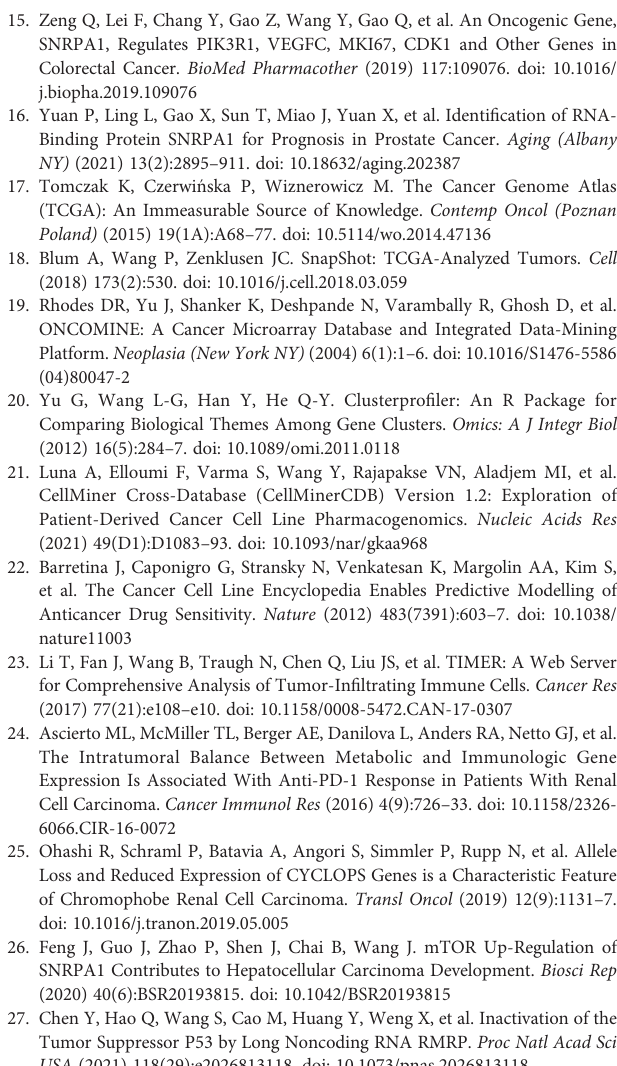
Supplementary Table 1 | Clinical features of the patients enrolled in SMMU cohort. Supplementary Figure 1 | Association between SNRPA1 expression and tumor stage in pan-cancer. Supplementary Figure 2 | Prognosis value of SNRPA1 in out-house datasets. Supplementary Figure 3 | SNRPA1 positively linked with the increased score of immune exclusion. Supplementary Figure 4 | (A) Know-out effect of SNRPA1 in 786-O and OS- RC-2 cell lines. (B) Cell proliferation of 786-O and OS-RC-2 after transfected with NC and SNRPA1 cas9-sgRNA plasmid, ***P<0.001. Supplementary Figure 5 | (A) Correlations of SNRPA1 expression with HALLMARKS enrichment score in 33 cancer types. (B-G) Correlation between SNRPA1 expression and HALLMARK_MYCC_TARTGETS_V2, HALLMARK_MYCC_TARTGETS_V1,